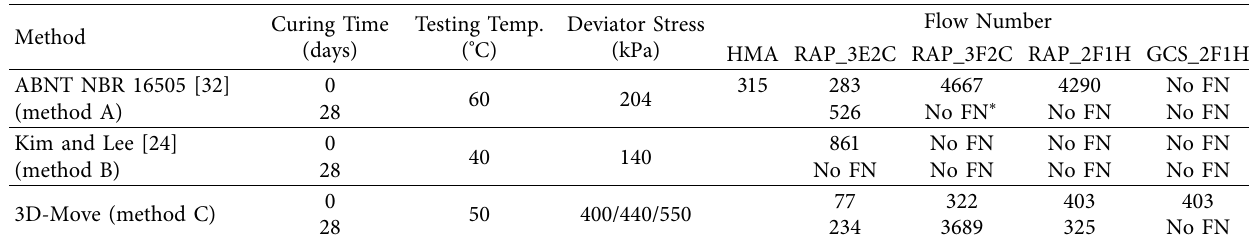
Table 2: Flow Number test conditions and test